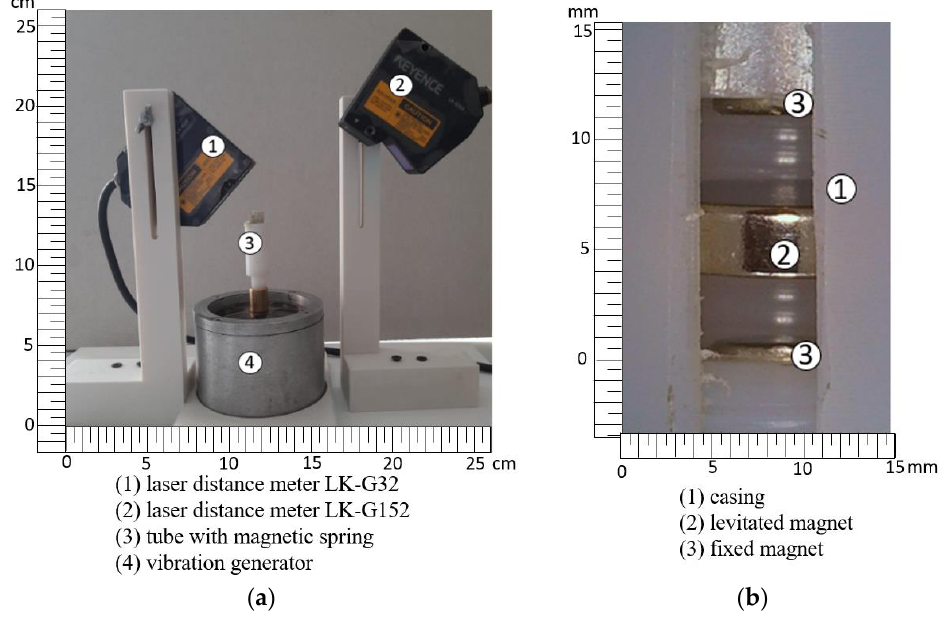
Figure 1. ( a ) Measuring station for the vibration generator and movable magnet position. (1) LK- G32, (2) LK-G152, (3) magnetic spring, (4) vibration generator [17], ( b ) magnetic spring (1) the casing of the magnetic spring, (2) the levitated magnet, (3) fixed magnets.